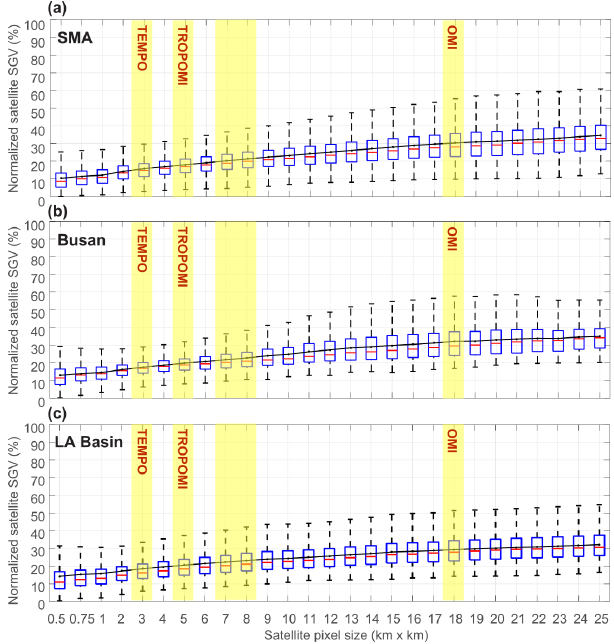
Figure 4. Boxplot (with medians represented by red bars, interquar- tile ranges between 25th and 75th percentiles represented by blue boxes, and the most extreme data points not considered outliers represented by whiskers) for the normalized satellite sub-grid vari- ability (SGV) over the Seoul Metropolitan Area (a) , the Busan re- gion (b) , and Los Angeles Basin (c) . Normalized satellite SGV is calculated as the standard deviation of the GeoTASO data within the sampled satellite pixel divided by the mean of the GeoTASO data within the sampled satellite pixel. The black lines represent the mean of the normalized satellite SGV at a given size. The resolu- tions of TEMPO, TROPOMI, GEMS, and OMI are highlighted by the yellow shading in the